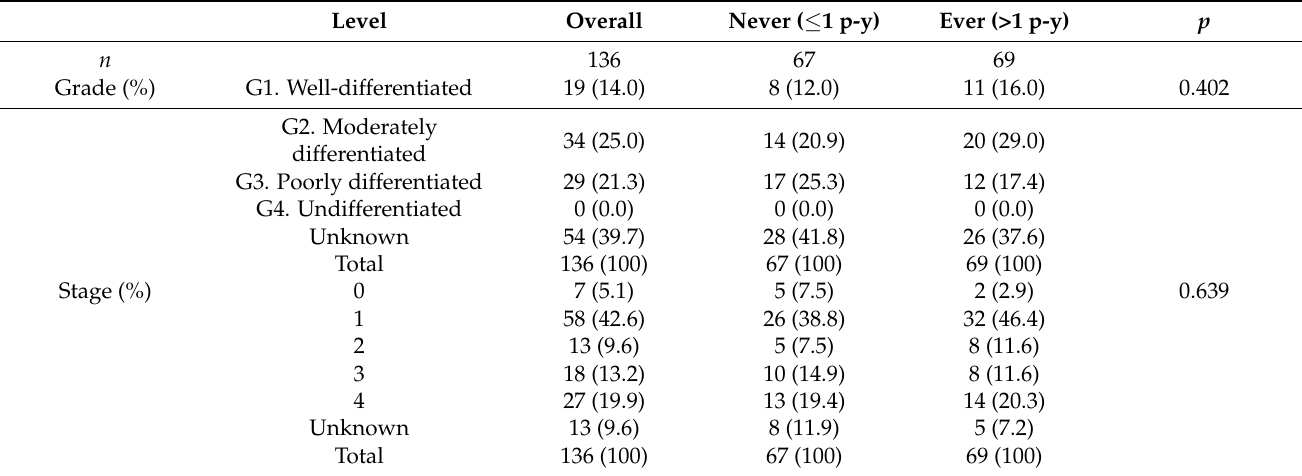
Table 2. Characteristics of women lung adenocarcinomas in the WTC Environmental Health Center with smoking history.